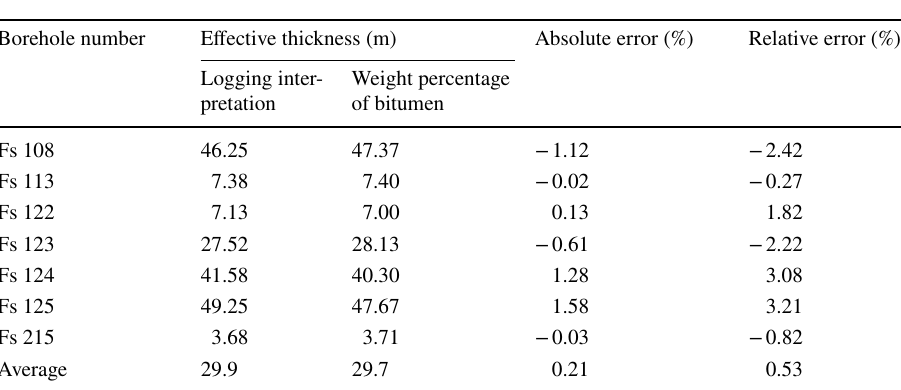
Table 3 Comparison of effective thickness calculated by logging interpretation and weight percentage of bitumen